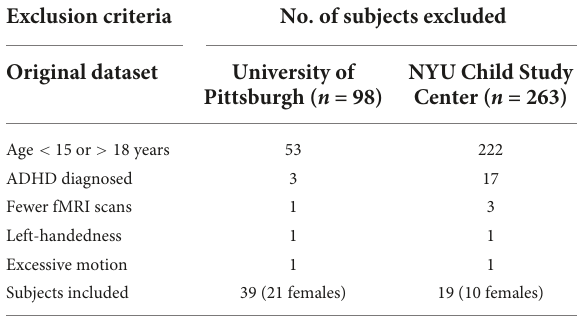
TABLE 1 Subject exclusion criteria for ADHD-200